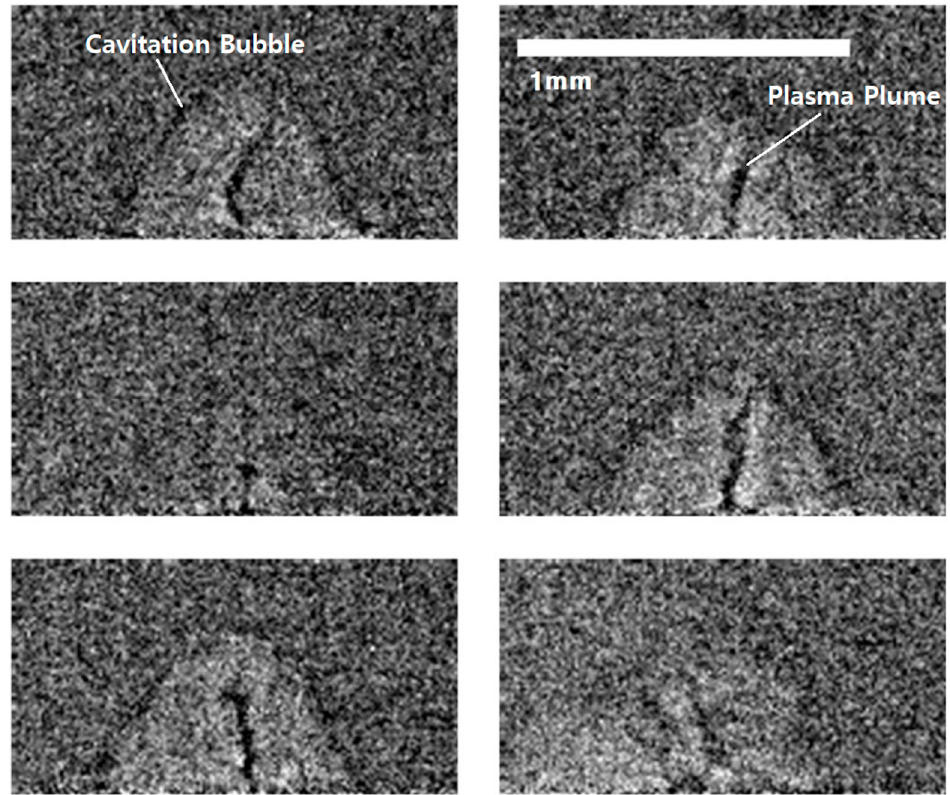
Figure 4. Representative individual radiographs from single laser shots at a fixed delay of ca. 320 microseconds, shows the variability of the plasma plume of phase VI (cavitation bubble collapse) (Reused with permission from ref. [50], copyright (2015), Nature).